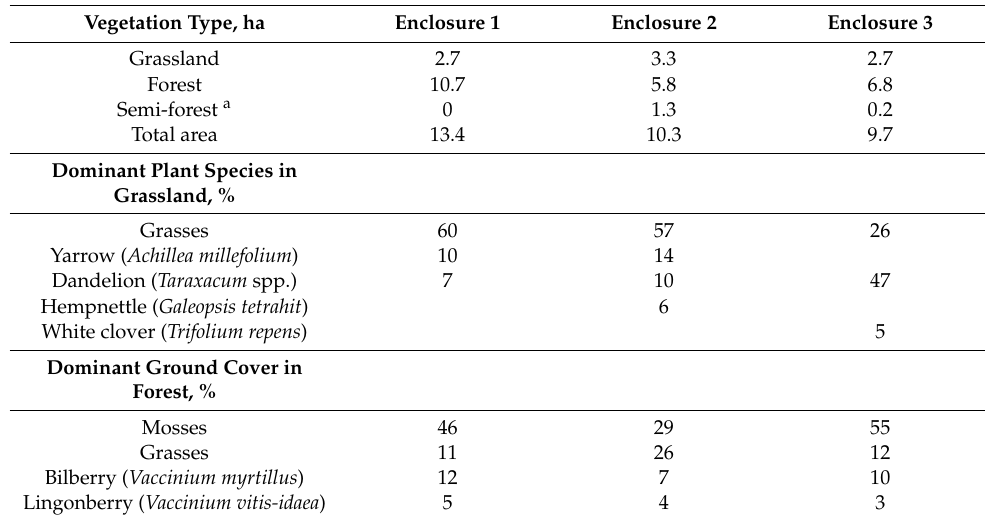
Table 1. Area (ha) of vegetation types within each enclosure and dominant plant species identified in a vegetation inventory performed in all three enclosures in May 2014 (study